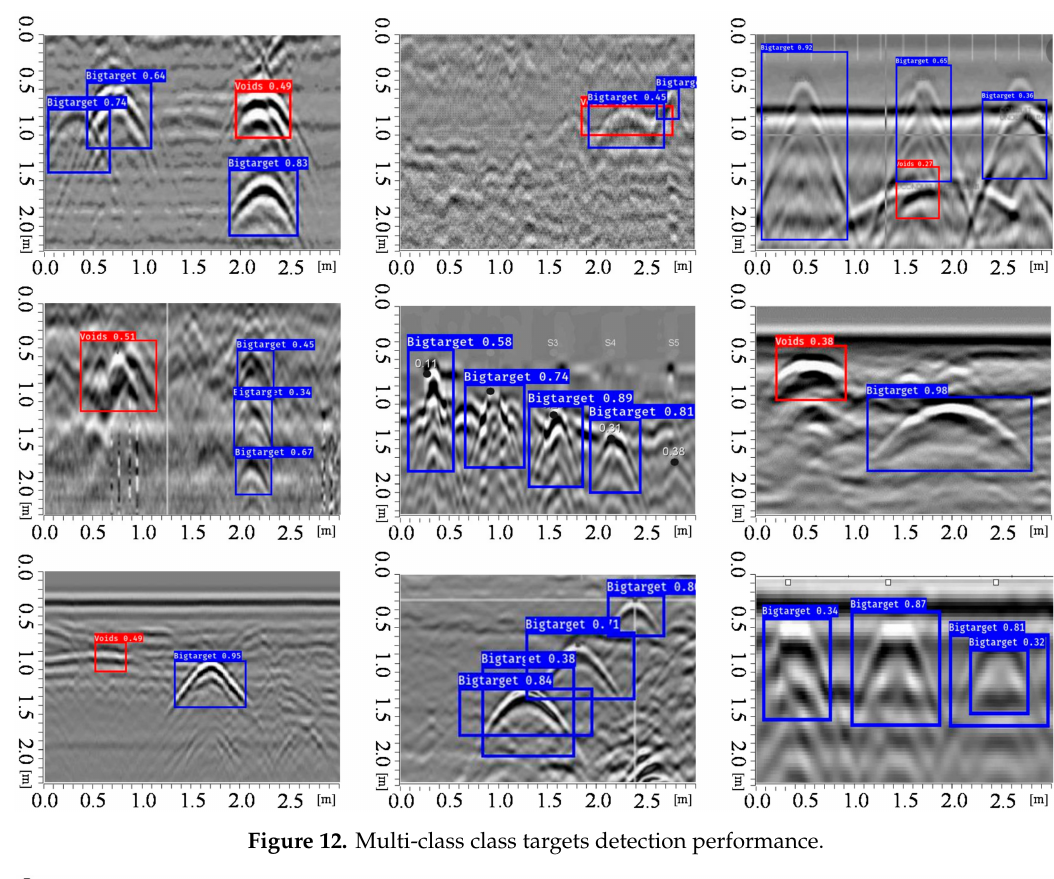
Figure 12. Multi-class class targets detection performance.